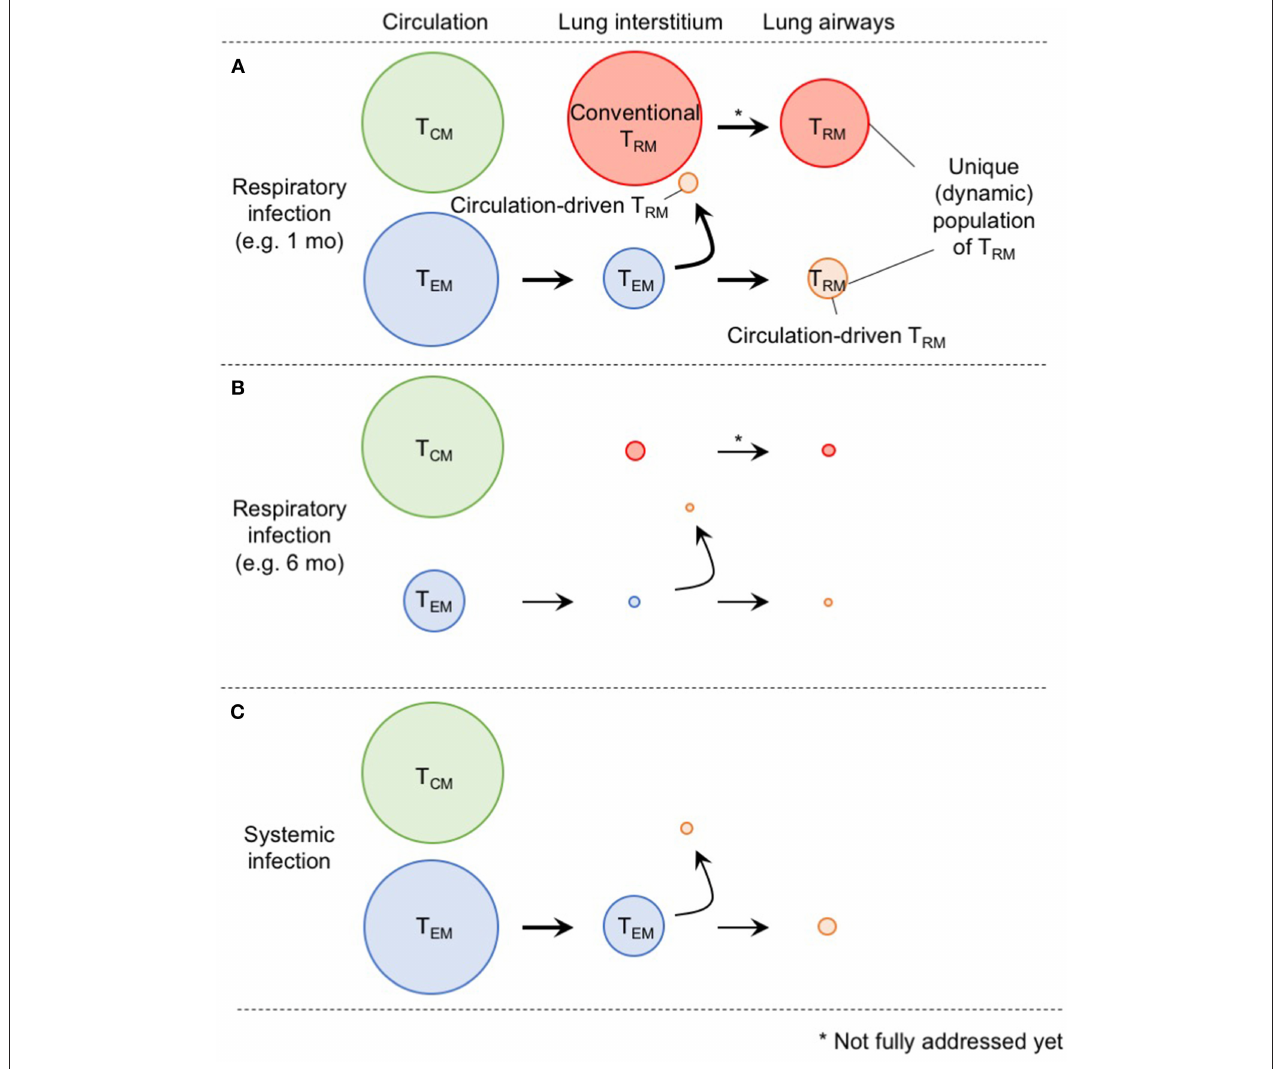
FIGURE 2 | A comprehensive picture of memory CD8 + T cell populations in the lung. (A) Memory CD8 + T cells in the lung interstitium comprise a major population of conventional T RM and a smaller population of T EM . Some of the latter also give rise to T RM in response to TNF secreted in the conditioned lung that experience prior virus infection. Both host and partner cells in the interstitium are likely recruited to the lung airways and undergo phenotypic changes induced by environmental factors in this tissue. Although lung airway memory CD8 + T cells represent non-circulating population, and thus, are recognized as T RM , continual replacement is required for their maintenance. The size of the circles indicates the relative sizes of the respective populations in the lung. (B) As T EM cells in the circulation decrease overtime after infection, input of T EM to the lung interstitium and airways also decrease. Full recovery from the tissue damage, and resultant decrease of the size of RAMDs leads to reduction in the number of host CD8 + T RM cells in the lung interstitium and airways. Consequently, the animals lost CD8 + T cell-mediated protective immunity in the lung. (C) Because of the lack of local antigen, bona fide CD8 + T RM cells are not generated in the lung interstitium and airways. Although some T EM cells give rise to T RM in the lung, the extent is less than infection-experienced